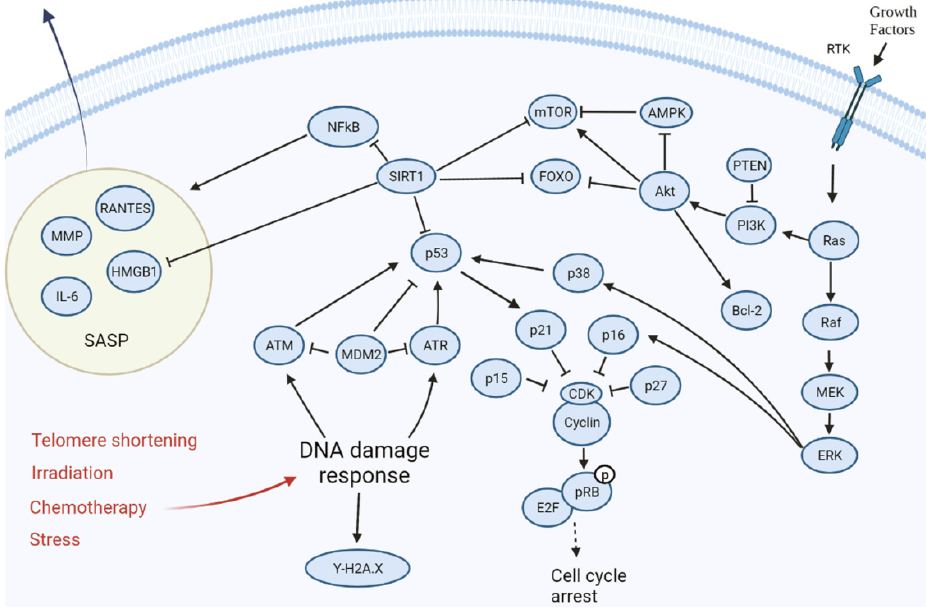
Figure 1. Simplified representation of signalling pathways related to cell senescence.